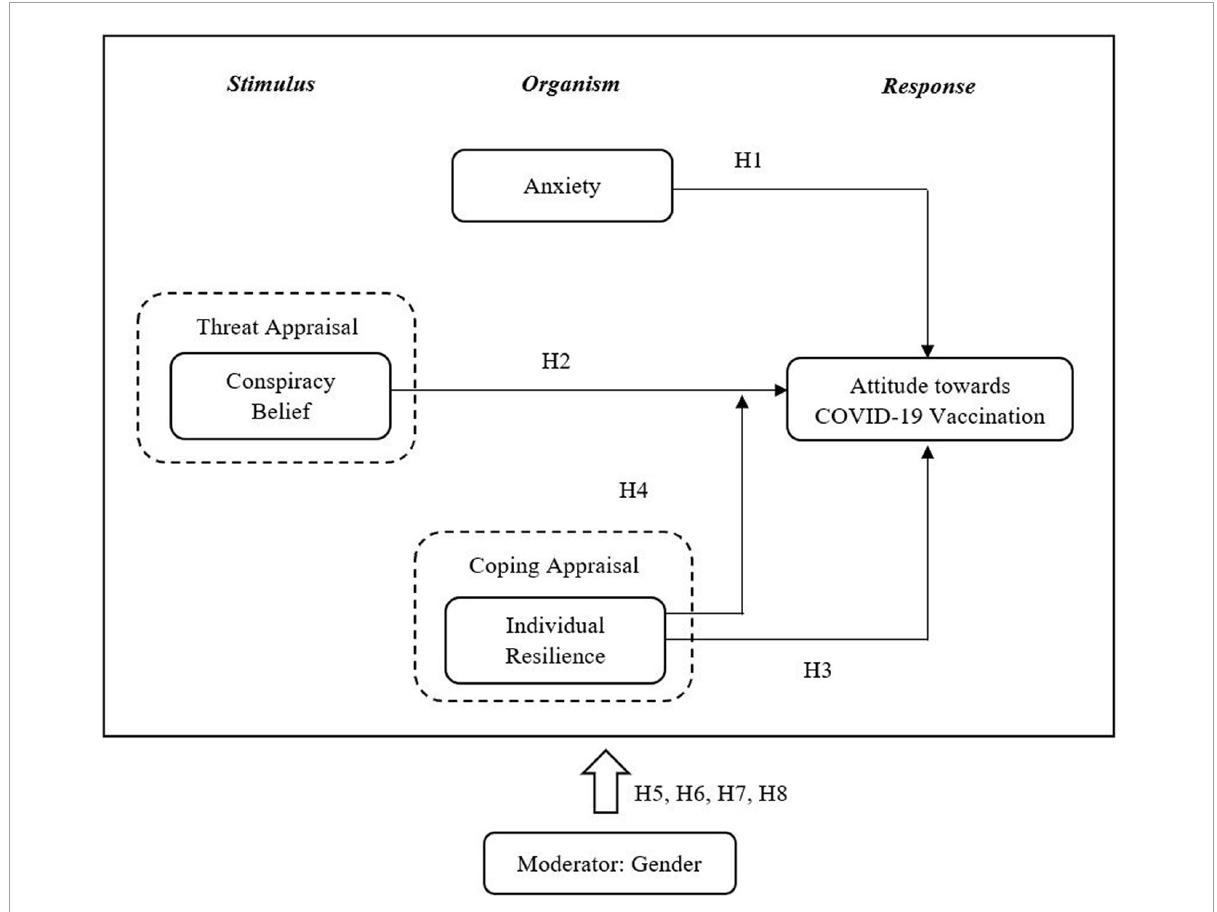
FIGURE1 Conceptual